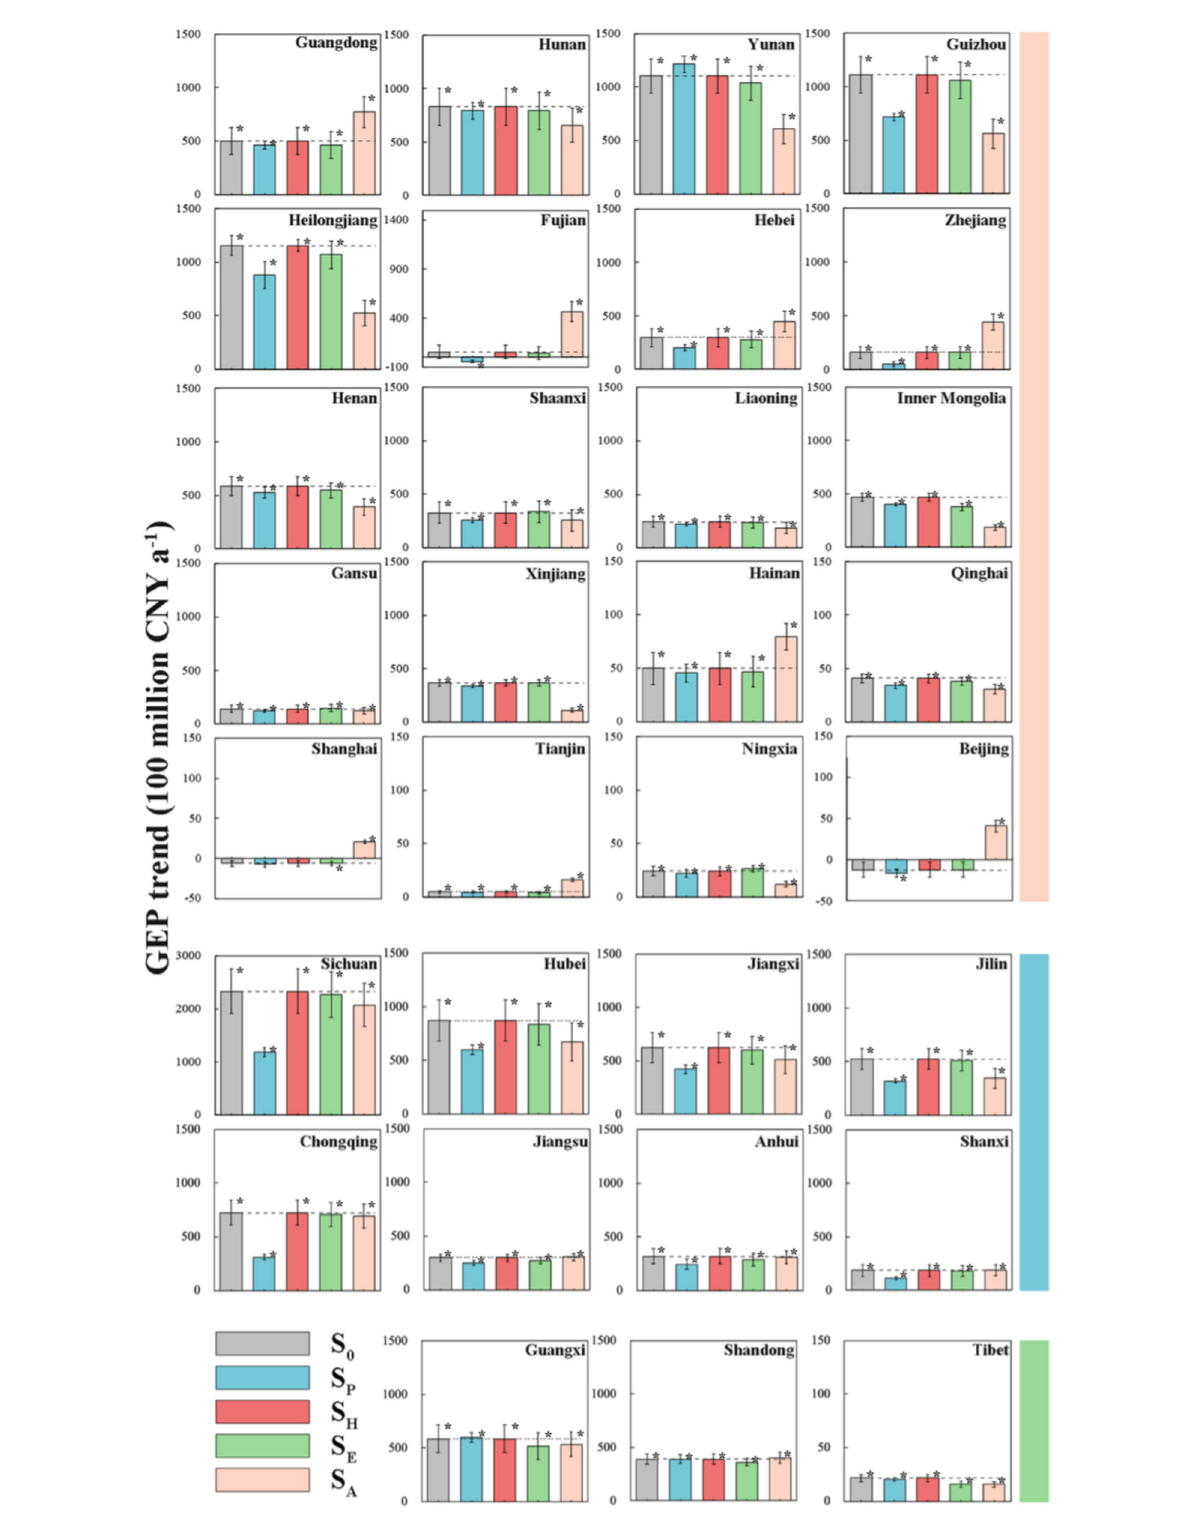
FIGURE4 Effects of natural and social-economic drivers on GEP for 31 provinces in China. S 0 , S P , S H , S E , S N , S A , S C , and S S represent the scenarios of normal, no variation in precipitation, high-temperature days, evapotranspiration, all three natural factors, planting area, product prices, and two social-economic factors, respectively. The dotted lines indicate the value of S 0 . * indicates significance at the 0.05 level. The colors of the rectangle on the right side indicate the dominant